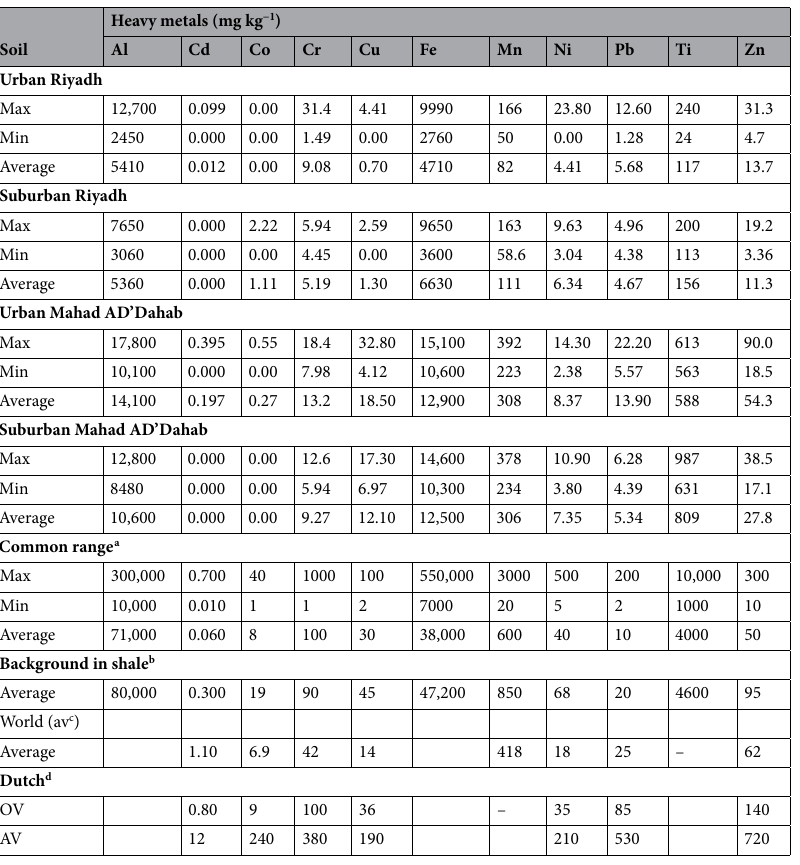
Table 1. Minimum, maximum and average content of heavy metals in soil samples of study area and average content of heavy metals values for world and Netherland soil. a Lindsay 50 . b Turekian and Wedepohl 33 . c Average concentrations for world soils (Huang et al. 75 ). d VROM 76